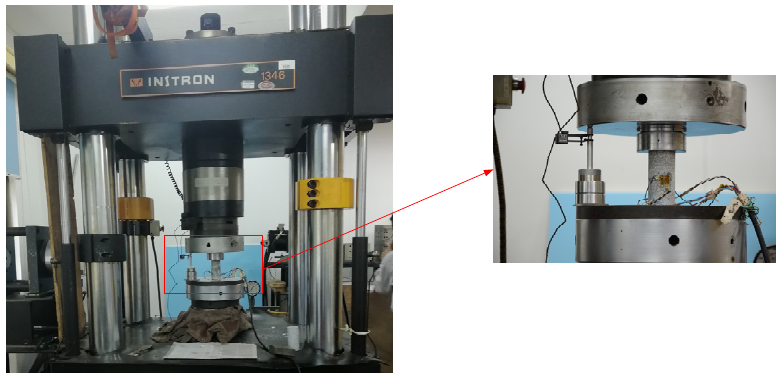
Figure 2. Experimental samples: ( a ) Uniaxial compression test sample. ( b ) Brazilian splitting test sample. ( c ) Three-point bending test sample.